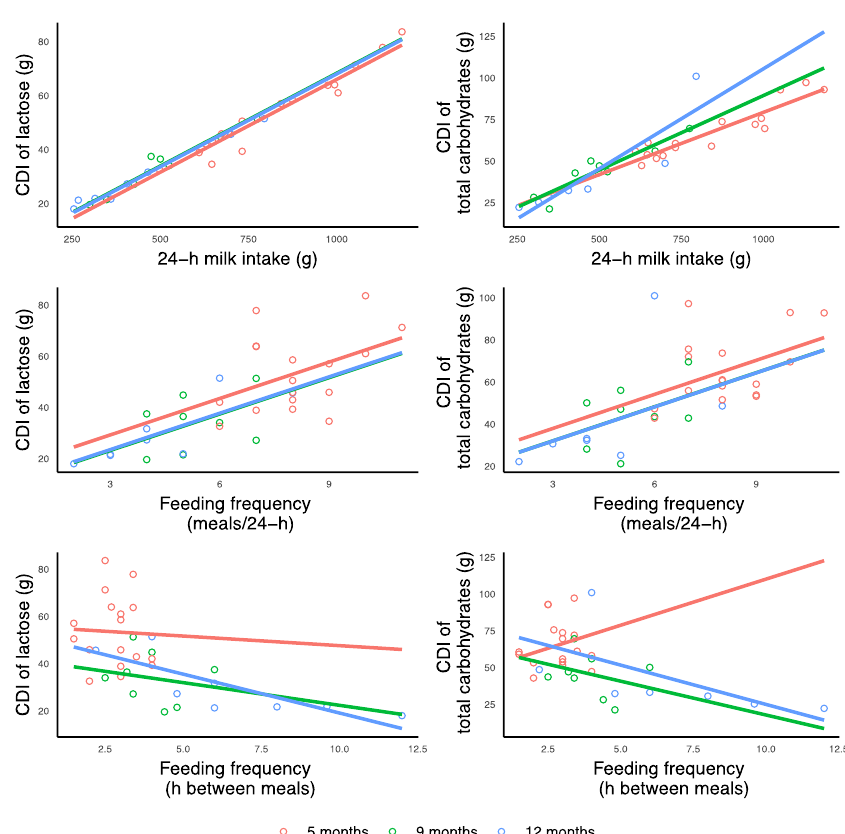
Figure 4. Significant associations between breastfeeding parameters and calculated daily intakes (CDI) of lactose and total carbohydrates measured during 24-h milk production. Lines represent linear regression and grouped by the month of lactation. Where is not seen, the linear regression line for 9 months (green) is under the 12 months line (blue) due to the similar intercept values.